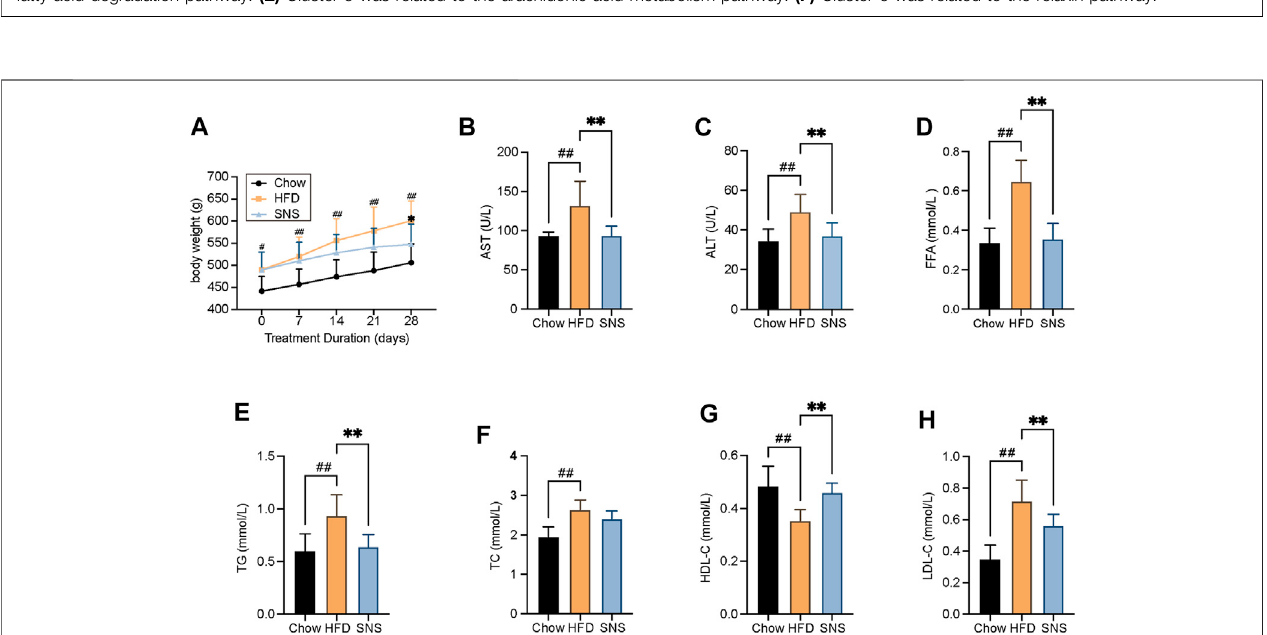
FIGURE 6 | Body weight and biochemical assays results after SNS treatment for rat NAFLD model. (A) Body weight measurement. (B) Serum aspartate aminotransferase (AST) levels. (C) Serum alanine aminotransferase (ALT) levels. (D) Serum free fatty acid (FFA) levels. (E) Serum total triglyceride (TG) levels. (F) Serum total cholesterol (TC) levels. (G) Serum high-density lipoprotein cholesterol (HDL-C) levels. (H) Serum low-density lipoprotein cholesterol (LDL-C) levels. Data are shown as mean ± SD (n (cid:2) 9). # p < 0.05, ## p < 0.01, ### p < 0.001 when compared with chow group. * p < 0.05, ** p < 0.01, *** p < 0.001 when compared with HFD group.